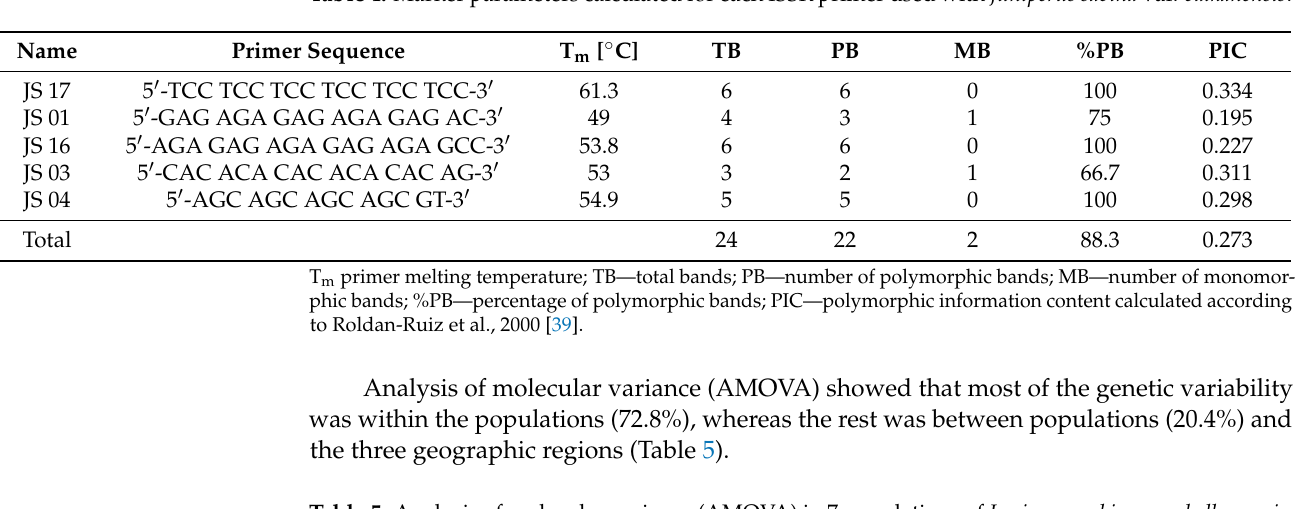
Table 5. Analysis of molecular variance (AMOVA) in 7 populations of Juniperus sabina var. balkanensis .